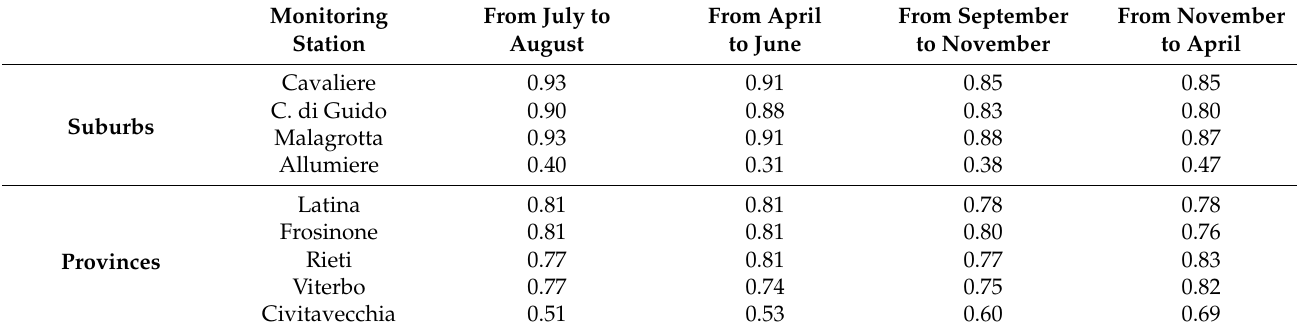
Table 9. Cross-correlation values between Roma Green Band and suburbs or province stations of [O 3 ] in 2015. Monitoring Station